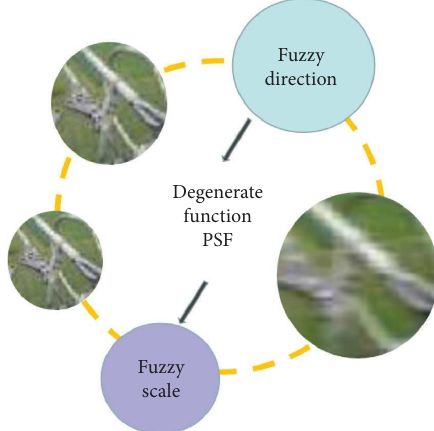
Figure 7: Motion blur patrol image synthesis.